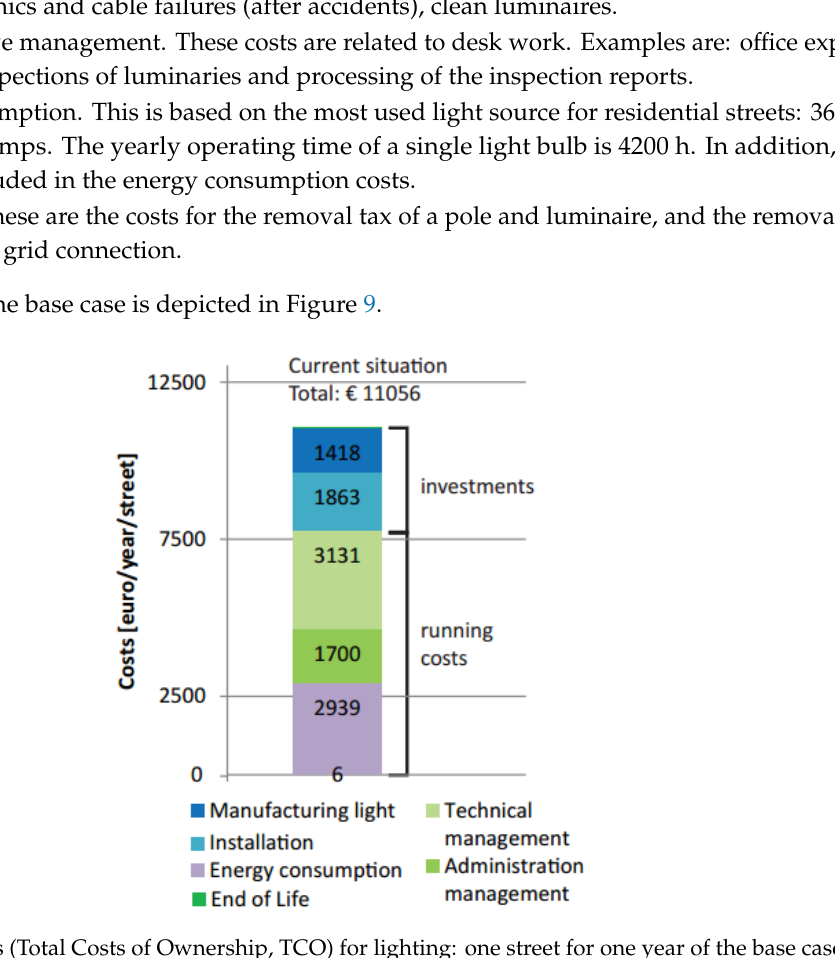
Figure 10. Eco-costs costs for lighting: one street for one year of the base case.